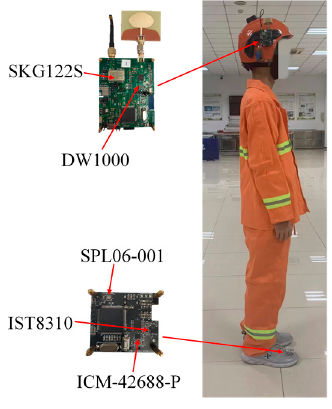
Figure 5. Sensor layout. Table 1. Con fi guration parameters of sensors and experimental setup.